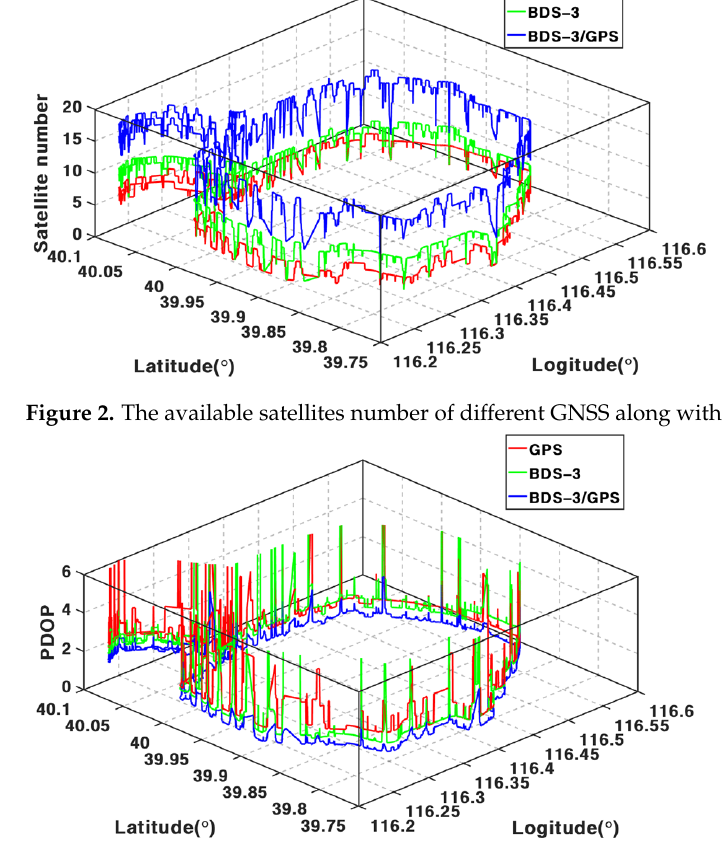
Figure 3. PDOP of different GNSS along with the test trajectory.